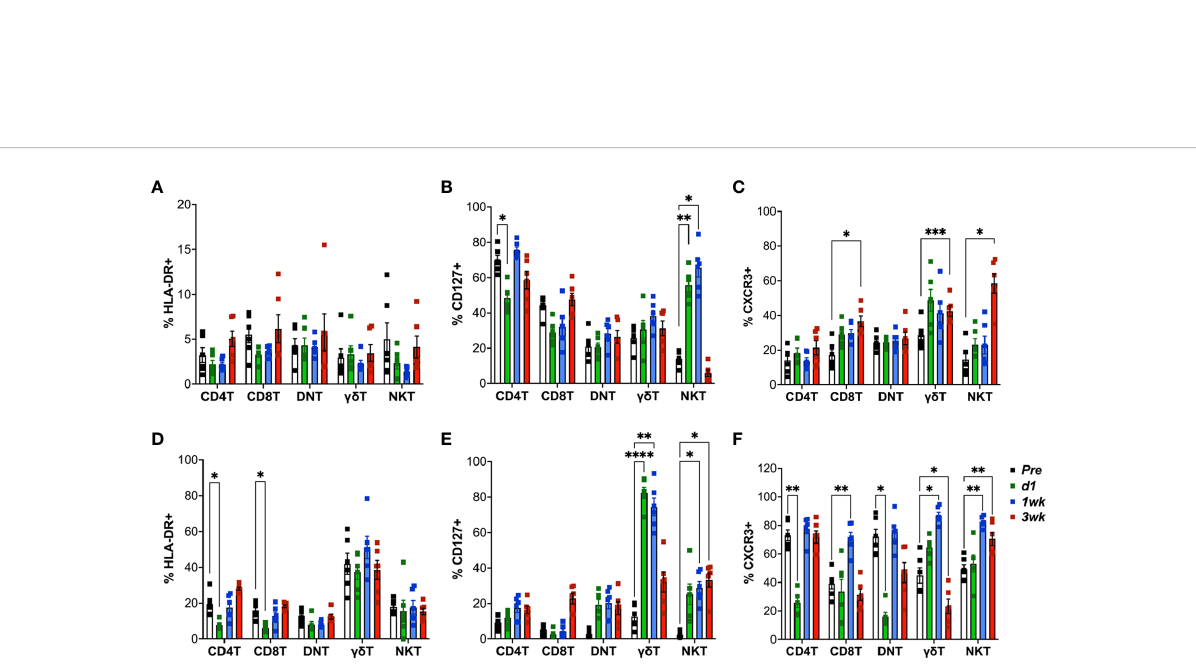
FIGURE 4 Expression of HLA-DR, CXCR3 and CD127 (IL-7R) on T cell subsets following aerosol BCG exposure. Frequencies of CD4 T, CD8 T, DNT, gd T, and NKT cells in PBMCs (top panel) and BAL cells (bottom panel) expressing HLA-DR (A, D) ; CD127 (B, E) ; CXCR3 (C, F) at pre-BCG inoculation (white bars) and d1 (green bars), 1wk (blue bars), and 3wk post-BCG (red bars) time-points. Comparisons of different time points with respect to pre-BCG baseline using repeated measures one-way ANOVA with Dunnett ’ s post hoc tests. Asterisks indicate signi fi cant differences between time points (*p < 0.05; **p < 0.01; ***p < 0.001; ****p < 0.0001).